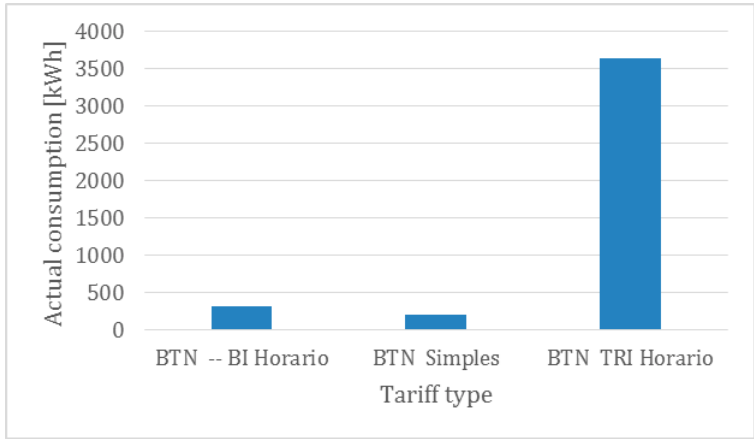
Figure 4. Actual consumption by tariff type.